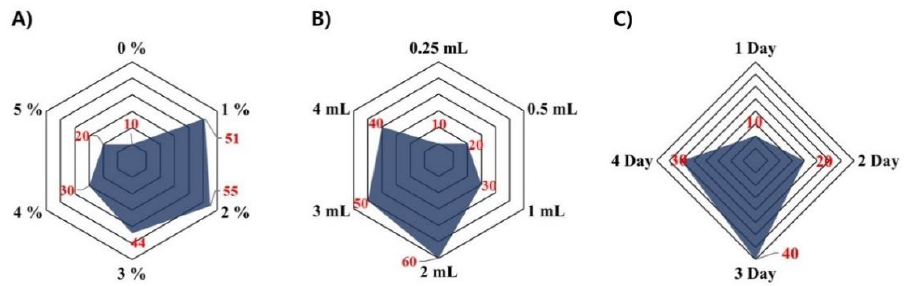
Figure 4. Quantitative descriptive sensory analysis, using 10 untrained volunteers, for establishing optimal process of the sheep placenta, fermented with B. deamine kh3, depending on ( A ) glycerol concentration, ( B ) volume of yeast suspension, and ( C ) fermentation period. The intensity evaluation of the sensory perception was performed by selecting structured scales of 0 (the worst smell) to 4 or 6 (the best smell; depending on the number of testing factors) at an interval of 1. Results were expressed as sum of individual score.